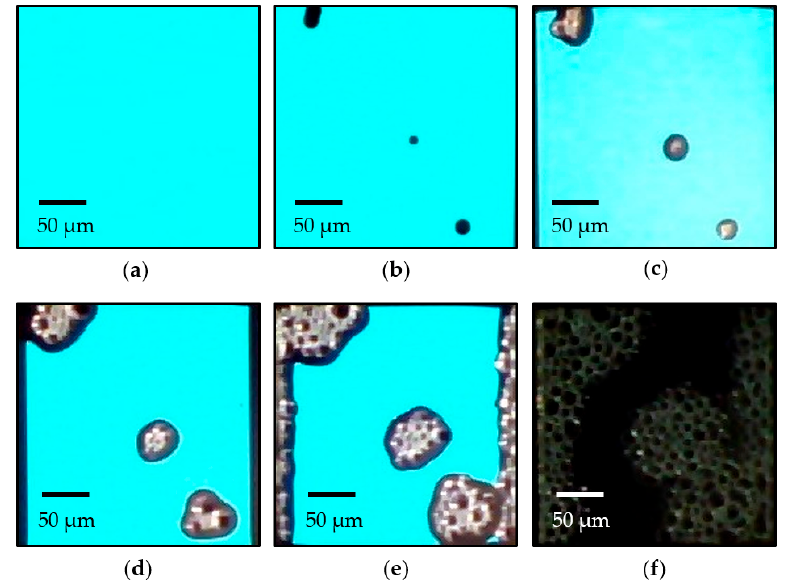
Figure 7. Photographs of the OLED devices with six-pair encapsulation for ( a ) 1200, ( b ) 1400, ( c ) 1600, ( d ) 1800, ( e ) 2000, and ( f ) 2200 h.